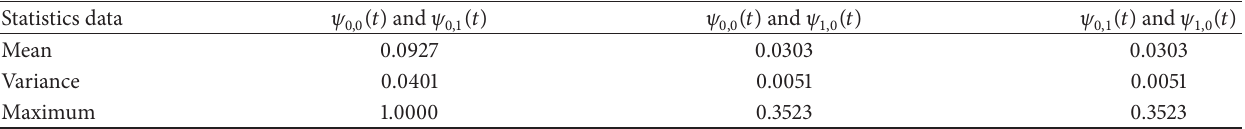
Table 3: Statistics of asynchronous mutual correlation values for sym8 wavelet.